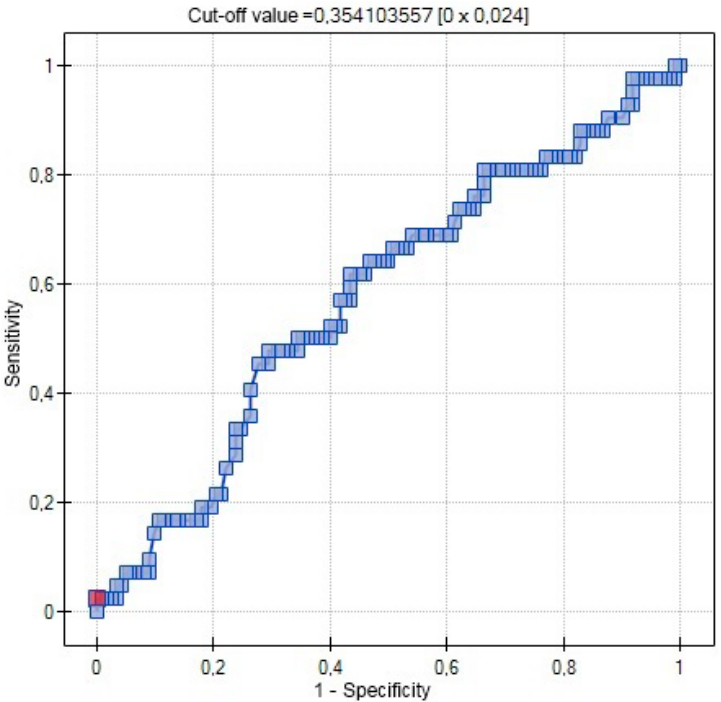
Figure 1. ROC curve relationship between 25(OH)D concentrations (ng/mL) and occurrence of gestational hypertension (red point—cut-off value).